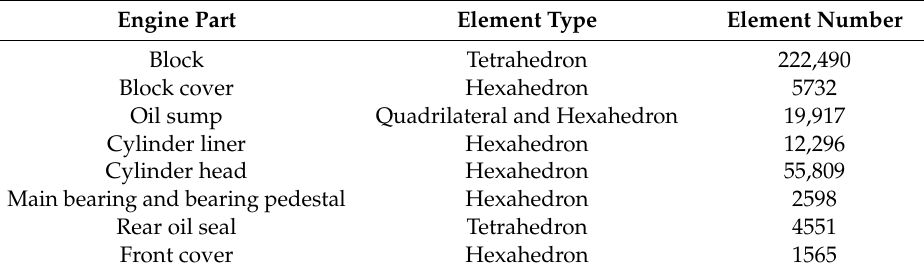
Table 1. Element type and element number of the diesel engine.